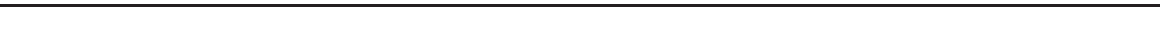
Table 2. Databases searched and the order of searching.